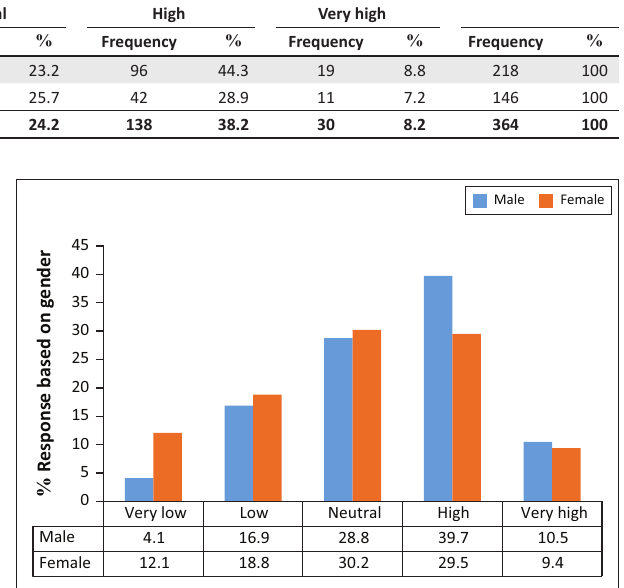
FIGURE 2: Courteousness of face-to-face service personnel.